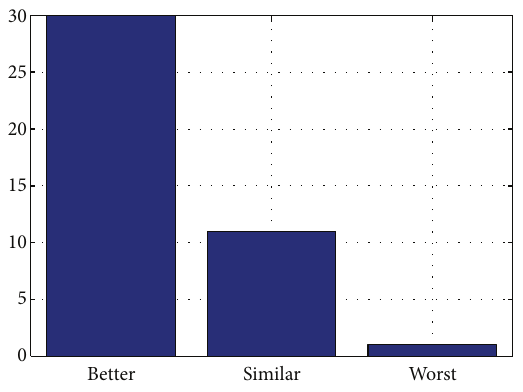
Figure 4: Performance comparison of EPDE2 and